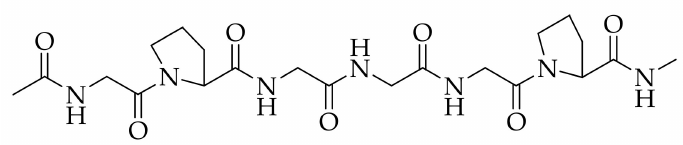
Figure 3. Chemical structure of